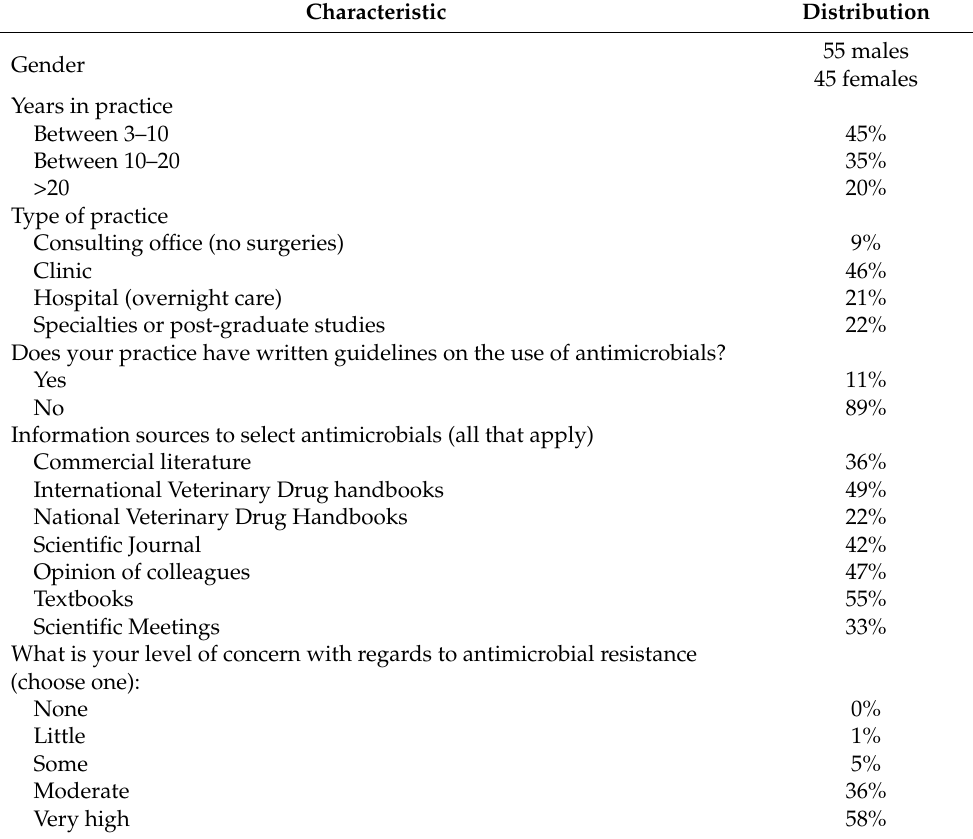
Table 1. Demographic characteristics of 100 veterinarians interviewed for a survey of antimicrobial practices in 2020 in Medellin, Colombia,